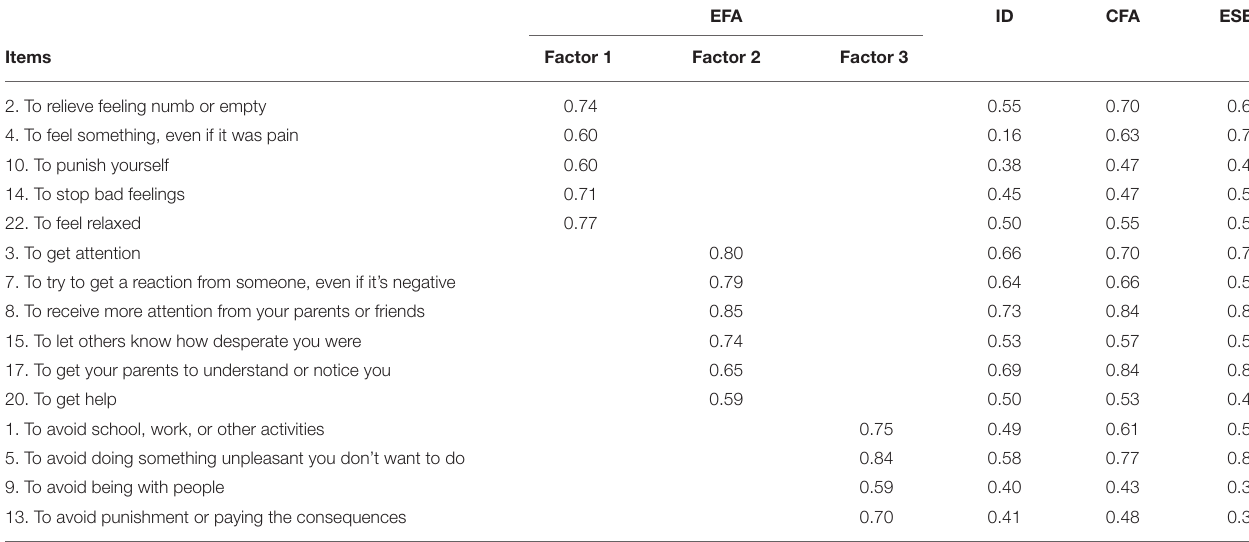
TABLE 3 | Standardized factor loadings for the three-factor models derived by EFA ( N = 319) and confirmed by CFA and ESEM ( N = 302). EFA ID CFA ESEM Items Factor 1 Factor 2